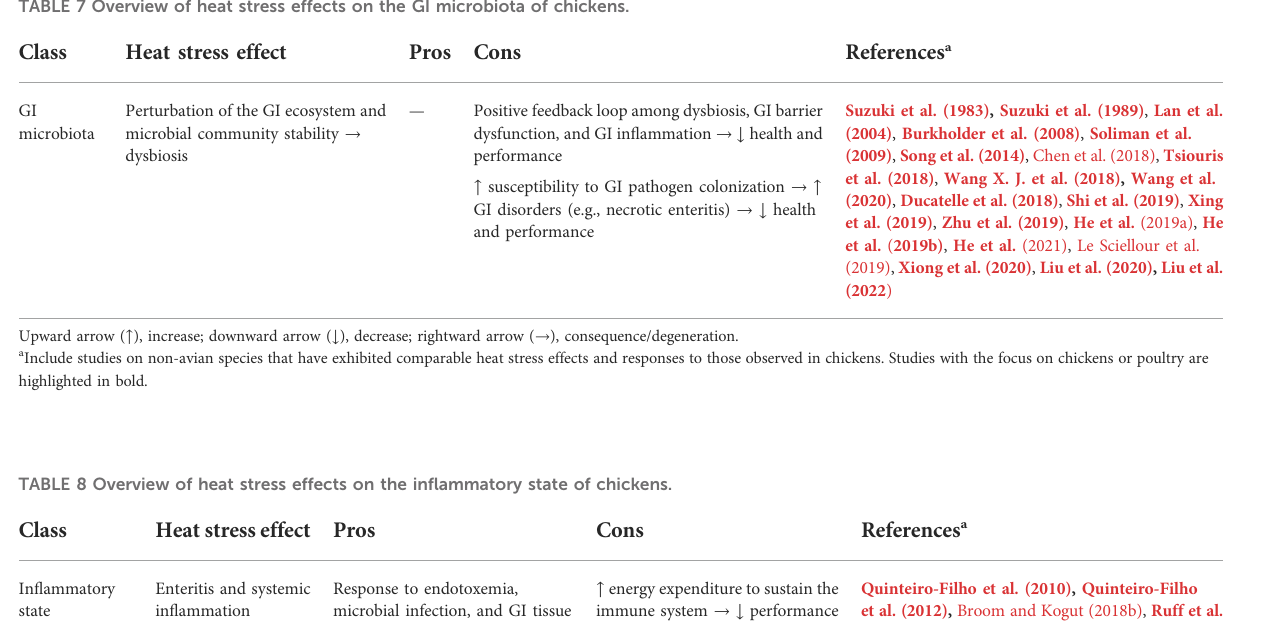
TABLE 7 Overview of heat stress effects on the GI microbiota of chickens.